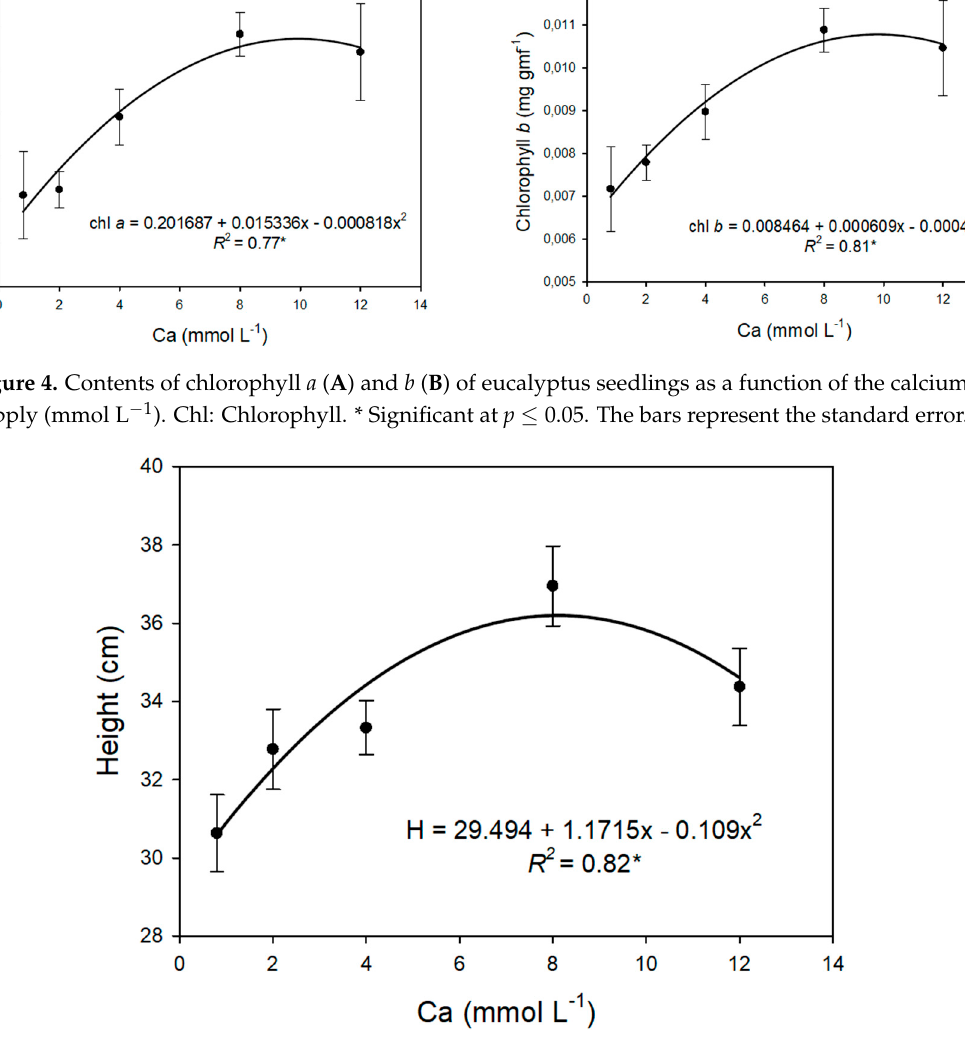
Figure 5. Effect of the calcium supply (mmol L − 1 ) on the height of eucalyptus seedlings. * Significant at p ≤ 0.05. The bars represent the standard error.